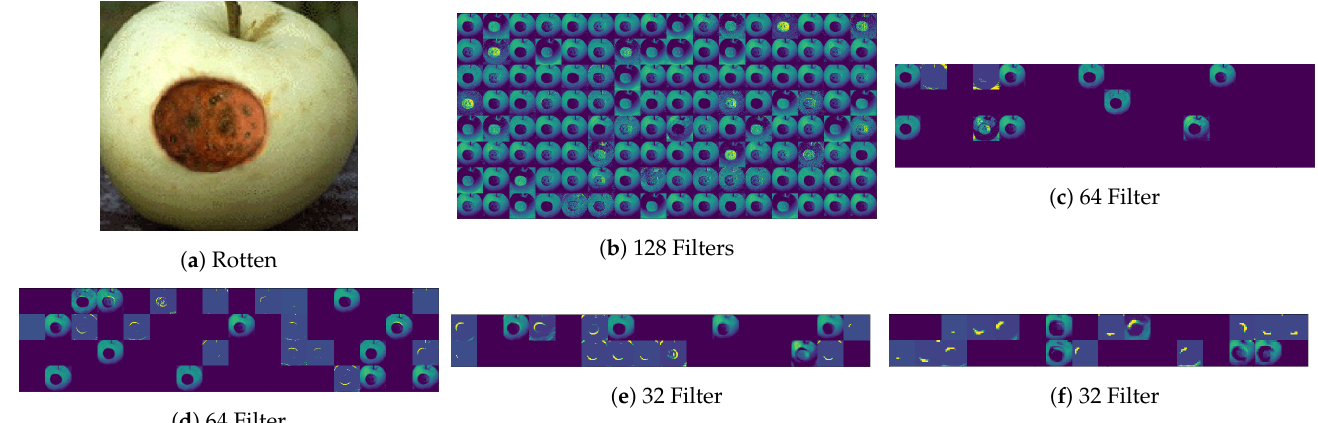
Figure 5. Feature extraction from convolutional filters. ( a ) Rotten apple, ( b ) 128 filters, ( c ) 64 filters, ( d ) 64 filters, ( e ) 32 filters, ( f ) 32